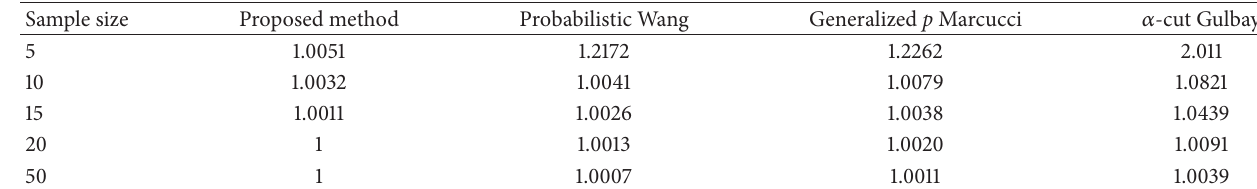
Table 5: ARL for different approach when there is a shift equal to 1.5𝜎 . 1